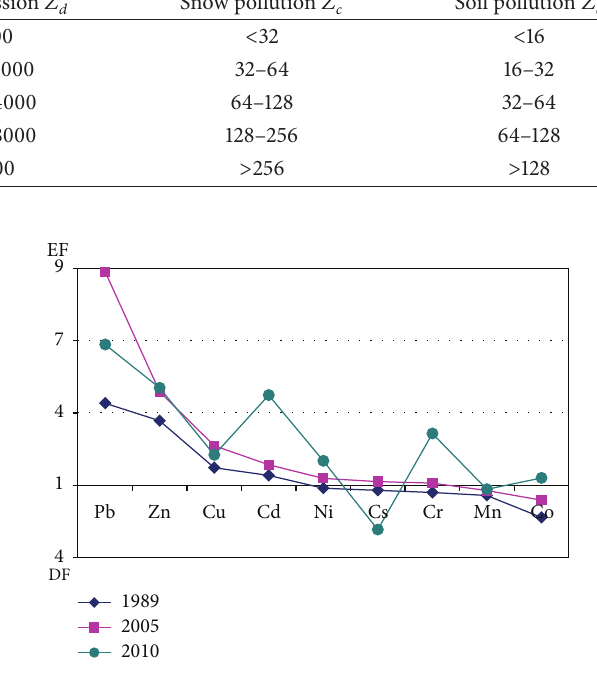
Figure 2: Geochemical spectra of urban soils in the Eastern district of Moscow showing enrichment and depletion factors (EF, DF) of metals in relation to background